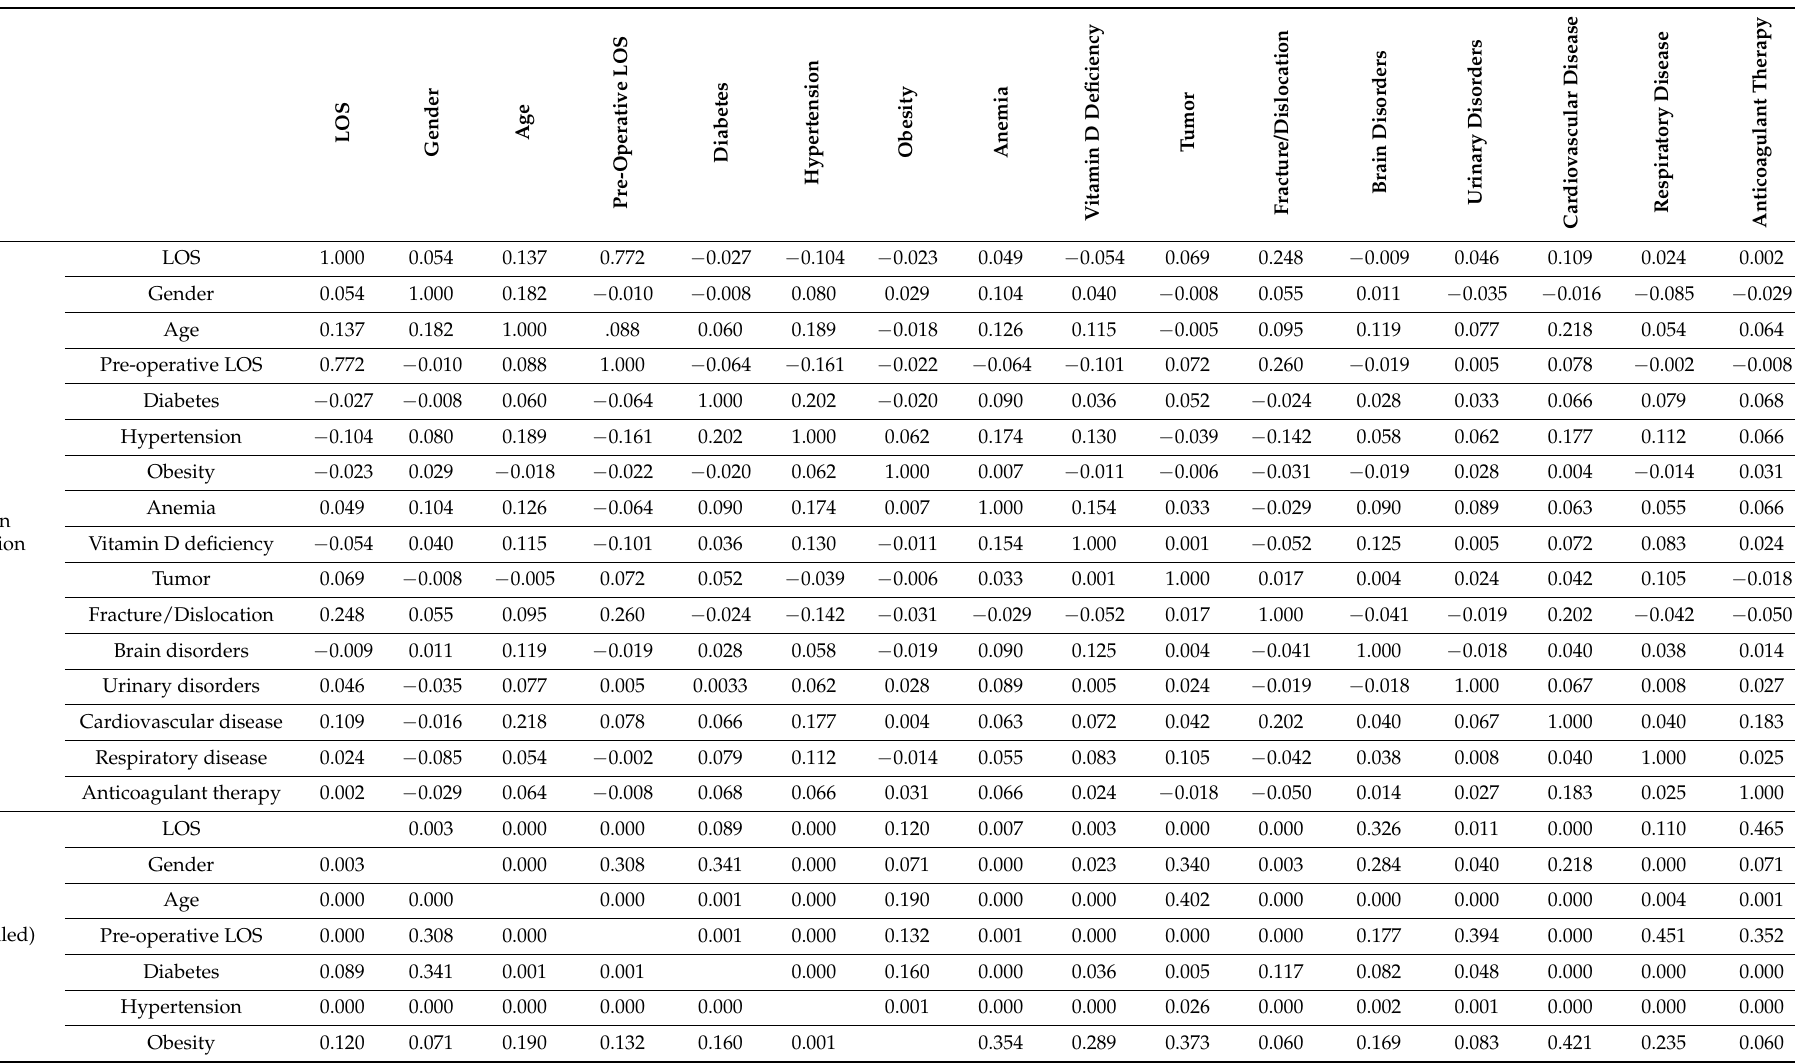
Table 1. Pearson